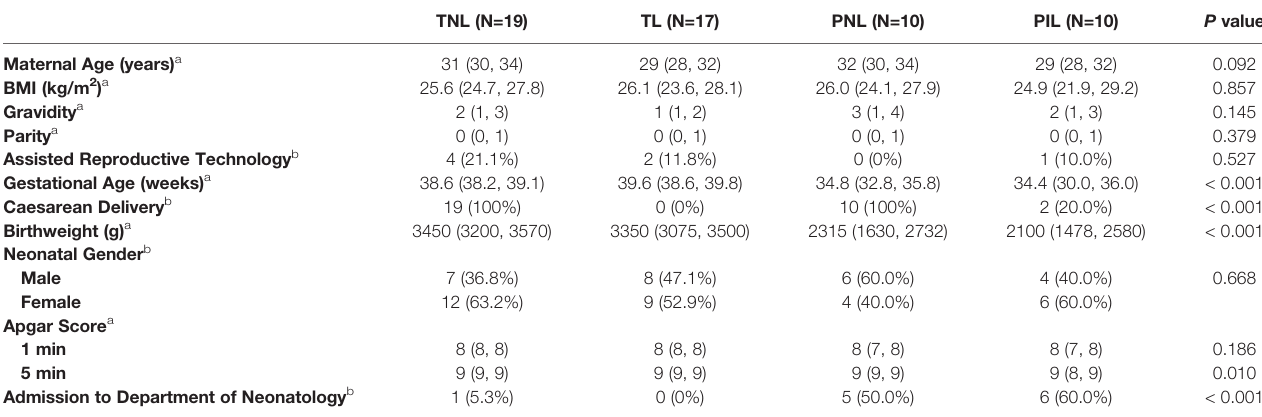
TABLE 1 | Clinical Characteristics of